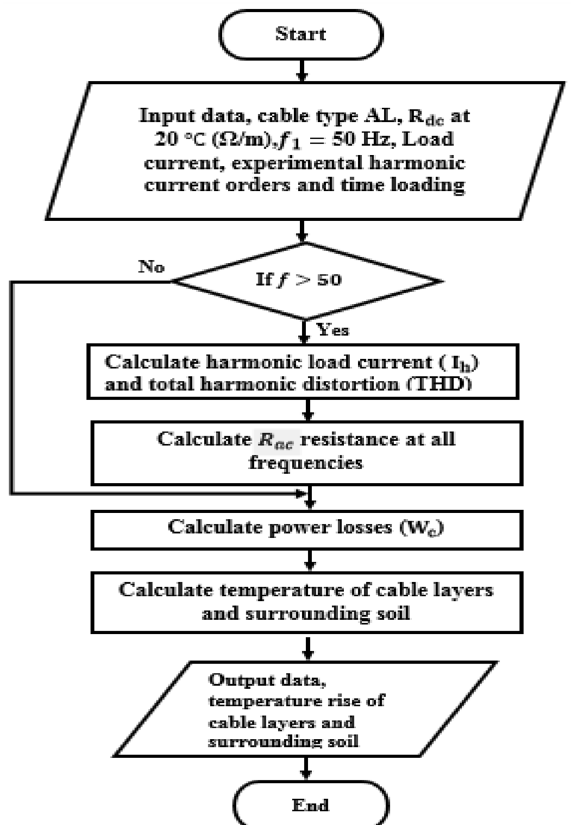
Fig. 11 Used flowchart of MATLAB